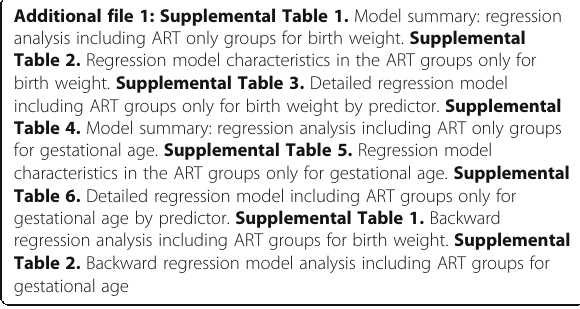
Table 2. Regression model characteristics in the ART groups only for birth weight. Supplemental Table 3. Detailed regression model including ART groups only for birth weight by predictor. Supplemental Table 4. Model summary: regression analysis including ART only groups